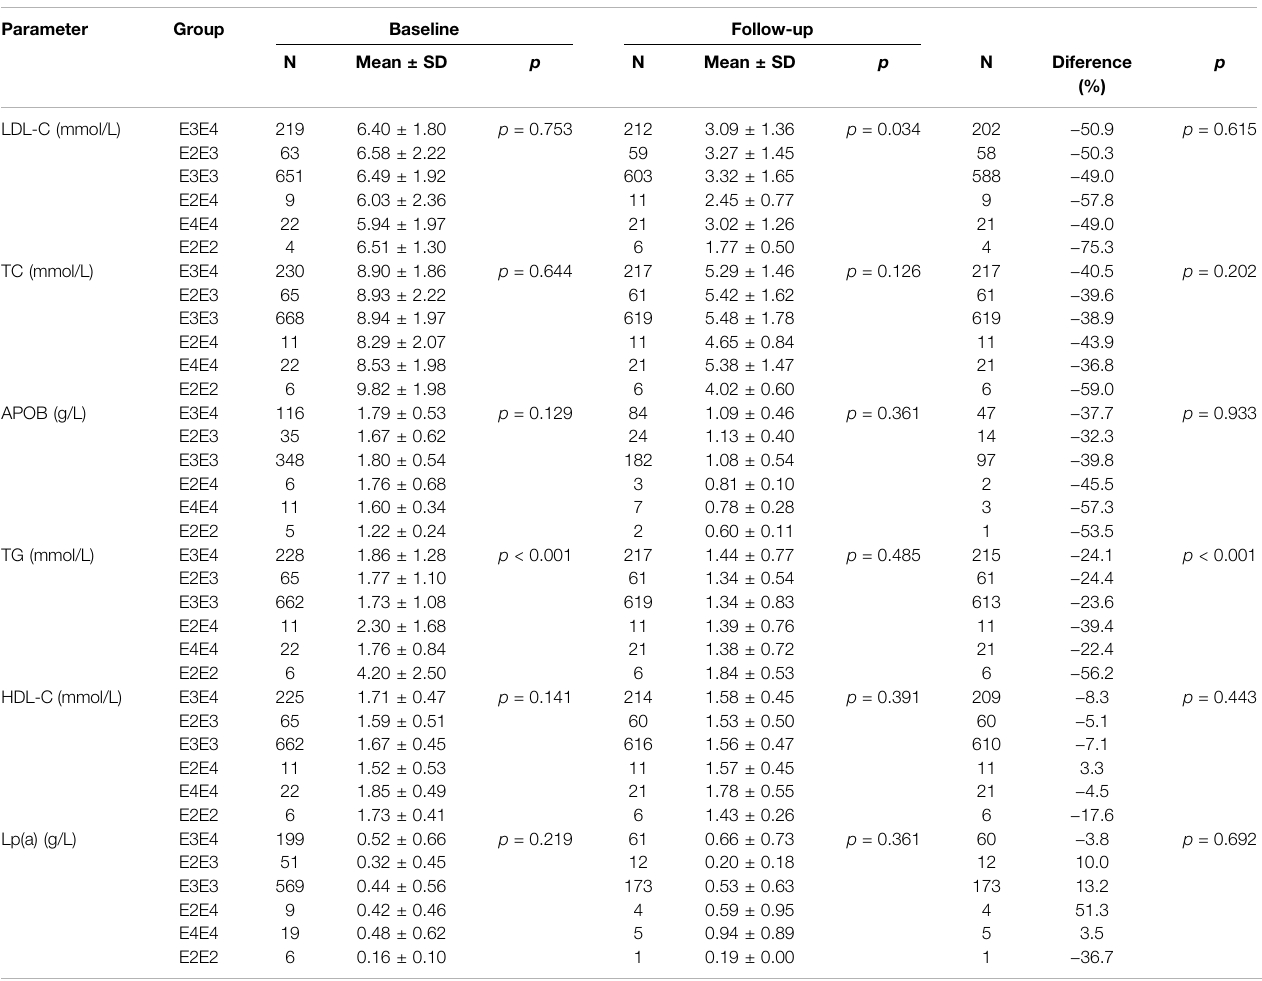
TABLE 4 | Patients with speci fi c APOE isoforms and effect of treatment on lipid levels. Parameter Group Baseline